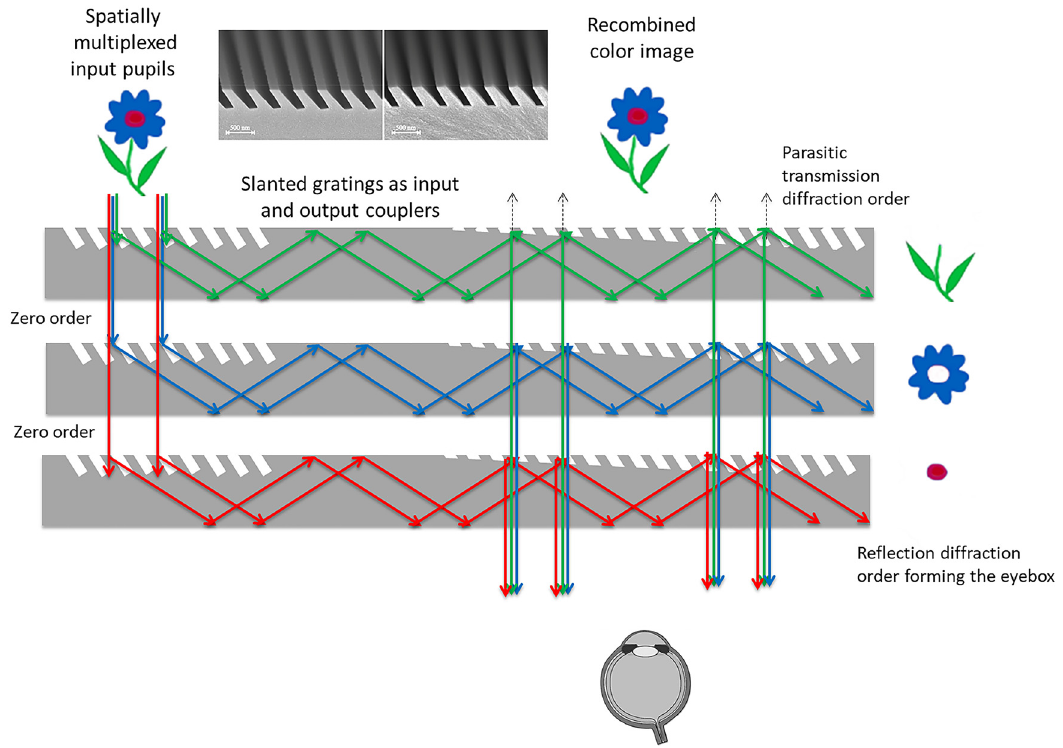
Figure 13: Spatially color-multiplexed input pupils with slanted gratings as in-couplers and out-couplers working in transmission and reflection mode (HoloLens 1 MR